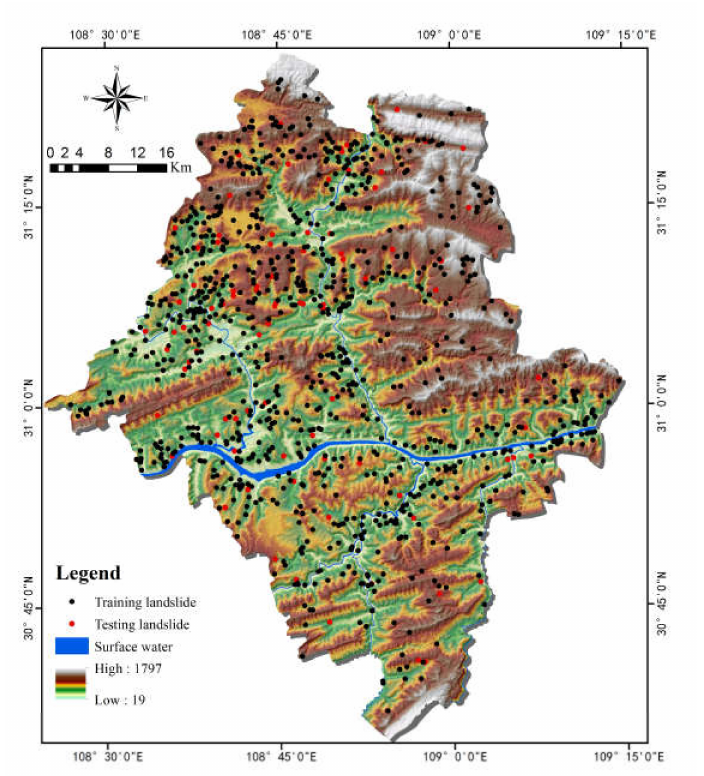
Figure 3. Landslide Inventory Map of the study